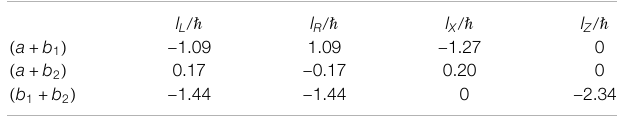
TABLE 1 | Angular momenta of the two phenol rings l L ≡ l L ( t p ) · n L and l R ≡ l R ( t p ) · n R , and the resulting angular momenta l X and l Z at the maximum coherence time t (cid:2) t p 1)